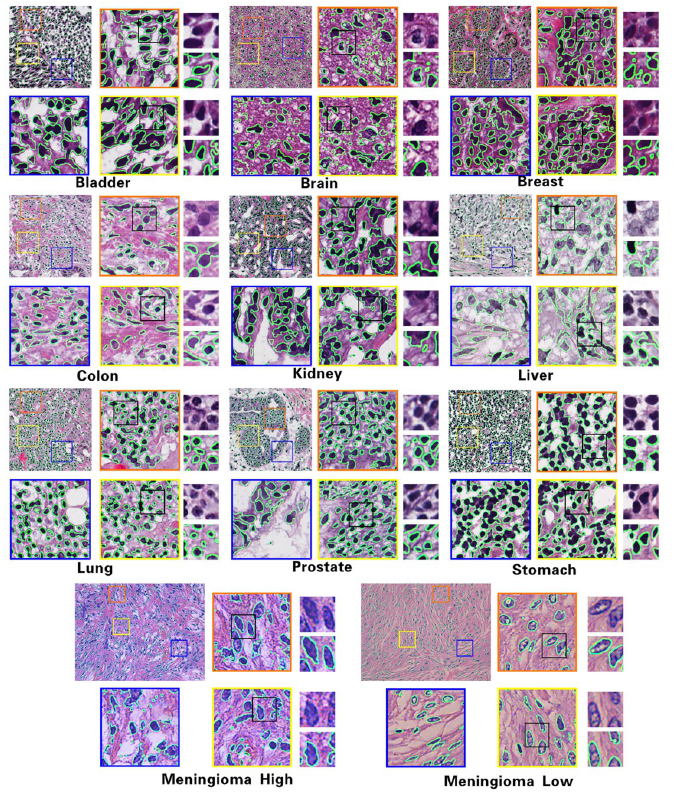
Fig 7. Samples segmentation results of multiple organs from three